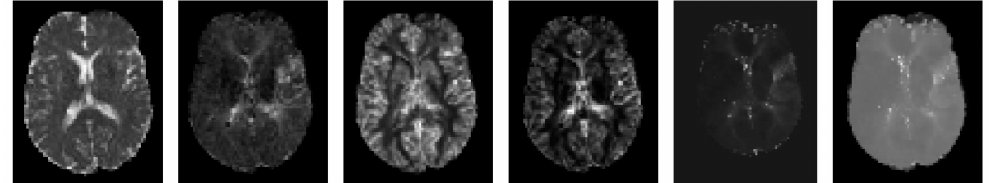
Figure 2. Center axial slice extracted from 3D volume resized to 150 × 150 × 21 of case no. 8. The shown maps are apparent diffusion coefficient (ADC), mean transit time (MTT), cerebral blood flow